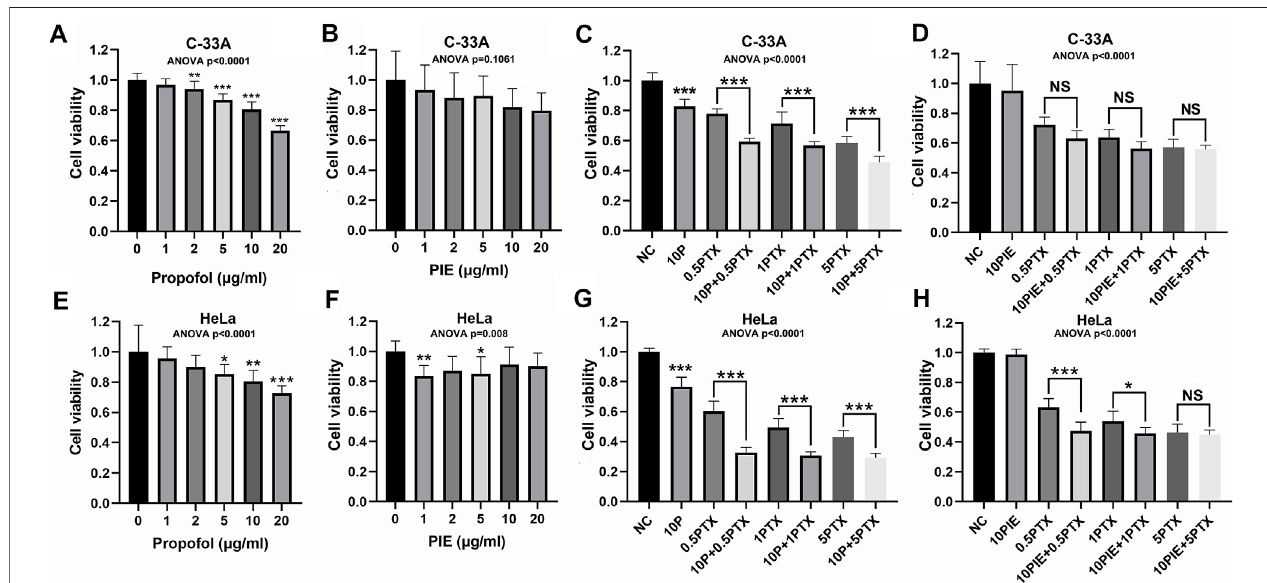
FIGURE 1 | Effects ofpropofolor PIE with or without paclitaxel on cell viability of C-33A and HeLa cells. (A,B) Effects of propofol/PIE on cell viability ofC-33A cells. (C,D) Combination effects of propofol/PIE with paclitaxel on cell viability of C-33A cells. (E,F) Effects of propofol/PIE on cell viability of HeLa cells. (G,H) Combination effects of propofol/PIE with paclitaxel on cell viability of HeLa cells. NS, no signi fi cant difference. * p < 0.05, ** p < 0.01, *** p < 0.001. 10P: 10 μ g/ml propofol; 0.5PTX: 0.5 μ g/ml paclitaxel; 10P+0.5PTX: 10 μ g/ml propofol plus 0.5 μ g/ml paclitaxel; 1PTX: 1 μ g/ml paclitaxel; 10P+1PTX: 10 μ g/ml propofol plus 1 μ g/ml paclitaxel; 5PTX: 5 μ g/ml paclitaxel; 10P+5PTX: 10 μ g/ml propofol plus 5 μ g/ml paclitaxel; 10PIE: 10 μ g/ml PIE; 10PIE+0.5PTX: 10 μ g/ml PIE plus 0.5 μ g/ml paclitaxel; 10PIE+1PTX: 10 μ g/ml PIE plus 1 μ g/ml paclitaxel; 10PIE+5PTX: 10 μ g/ml PIE plus 5 μ g/ml